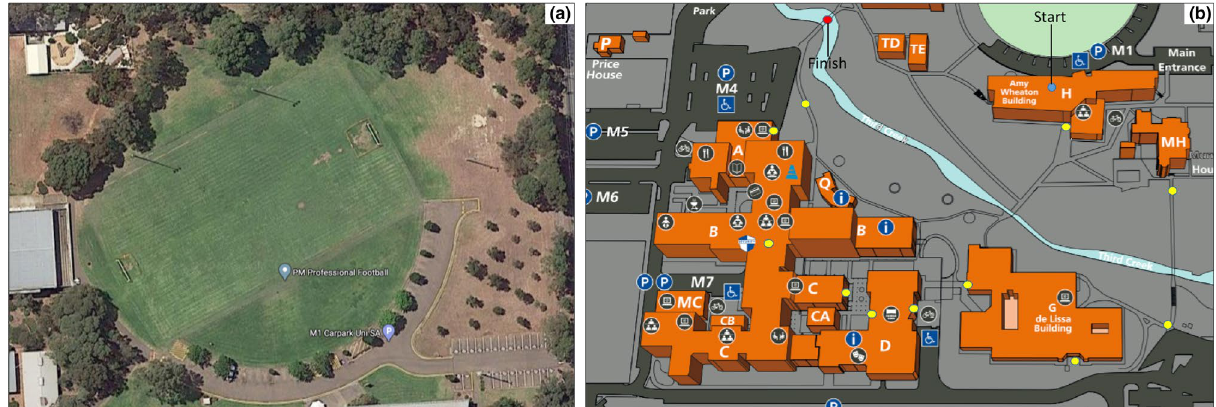
Figure 1. ( a ) Grass sports field at the Magill campus at the University of South Australia (from Google Maps, by Google, https:// bit. ly/ 2R0XX jl), ( b ) Reproduction of the map provided to the participants in the Campus condition, showing the route across the Magill campus. Participants began at the blue dot that represents the starting point and had to follow the yellow dots until they reached the red dot that represents the finish